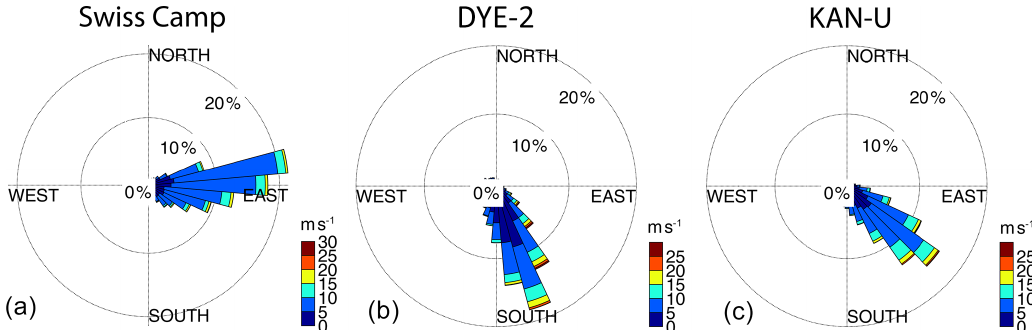
Figure A1. Prevailing wind distribution at Swiss Camp (a) , DYE-2 (b) and KAN-U (c)